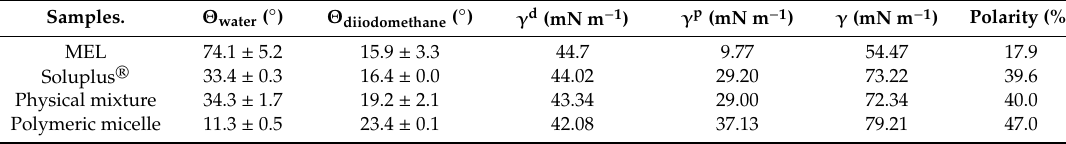
Table 4. Wetting properties of components and polymeric